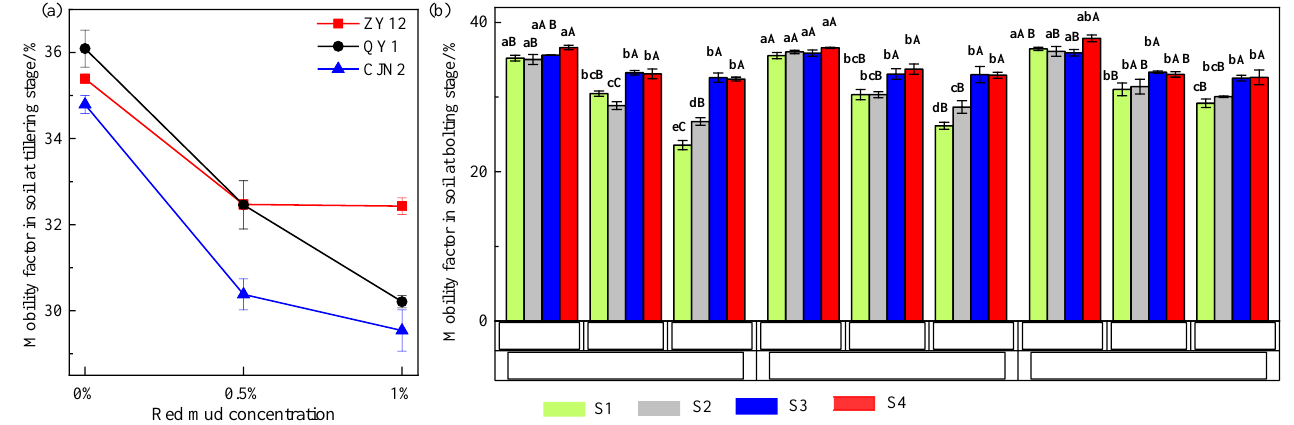
Figure 8. Effect of red mud (RM) on the cadmium (Cd) mobility factor of rhizoboxes. ( a ) the mobility factor of Cd in soil at tillering stage; ( b ) the mobility factor of Cd in soil at bolting stage. Different lowercase letters indicate a significant difference between rice cultivars under the different RM treatments ( p < 0.05). Different uppercase letters indicate a significant difference between soil zones ( p < 0.05).